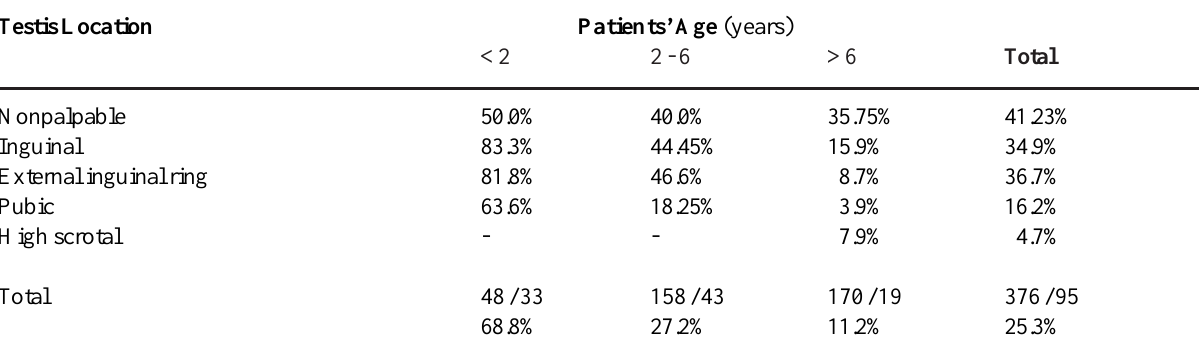
Table 2 – Incidence of PPV related to testis location and age group. Values are shown in percentages. Number of undescended testes associated with PPV / Total number of undescended testes. Testis